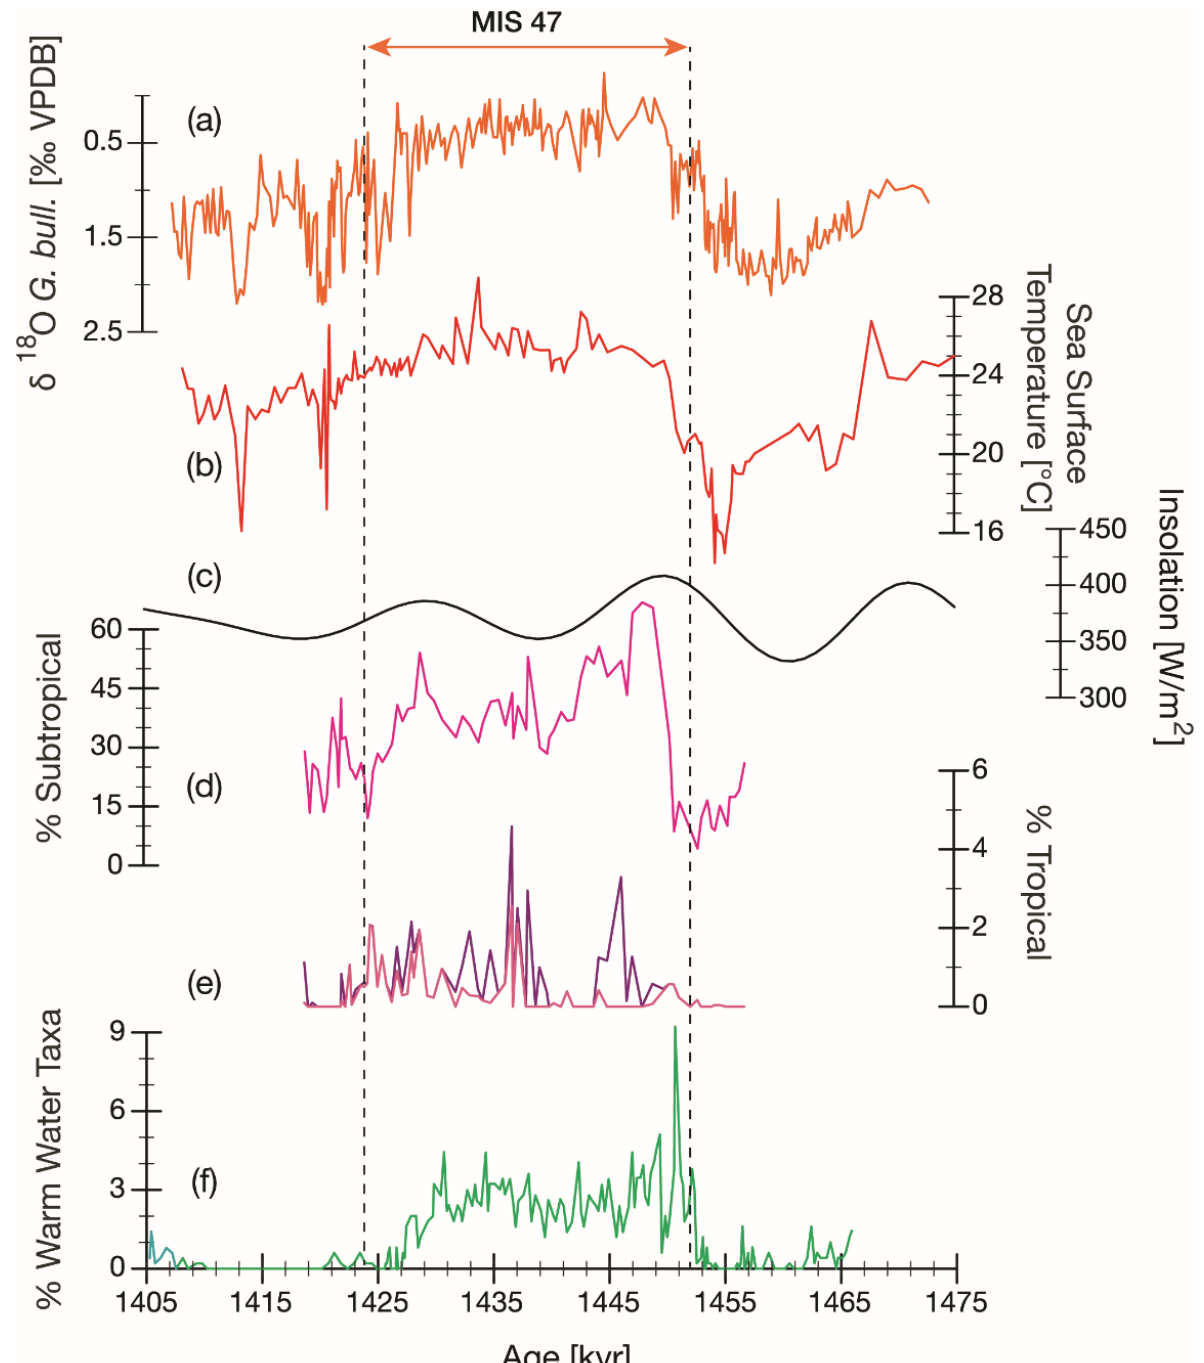
Figure 6. Focus on the warm water sphere during MIS 47: ( a ) G. bulloides δ 18 O record; ( b ) U k’ 37 sea surface temperatures; ( c ) summer (June – September) insolation at 65° N [63]; ( d ) percentage contribution of subtropical planktonic foraminifera to the assemblage; ( e ) percentage contribution of tropical planktonic foraminifera (purple) and just of subsurface dwelling, tropical species G. crassaformis (strawberry pink) to the assemblage; ( f ) Percentage of warm water taxa in the calcareous nannofossil